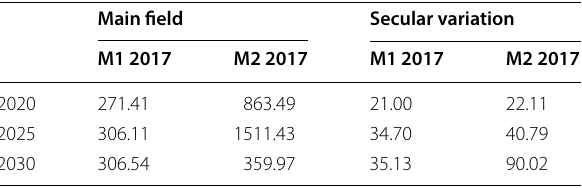
Table 2 The rms differences between models of different epochs and Model 1 and Model